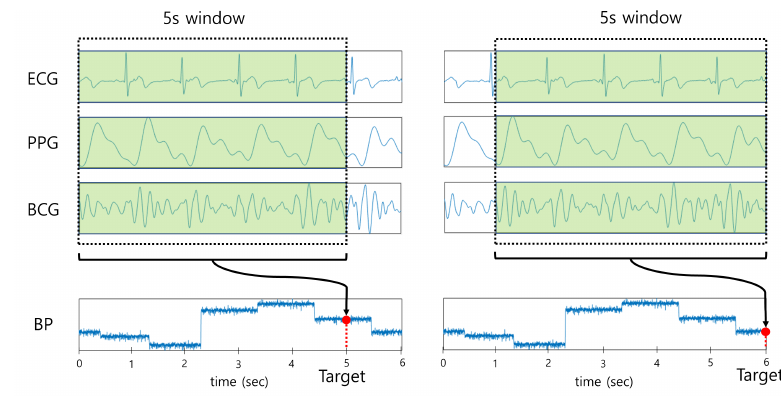
Figure 4. Data preprocessing of the deep learning model.